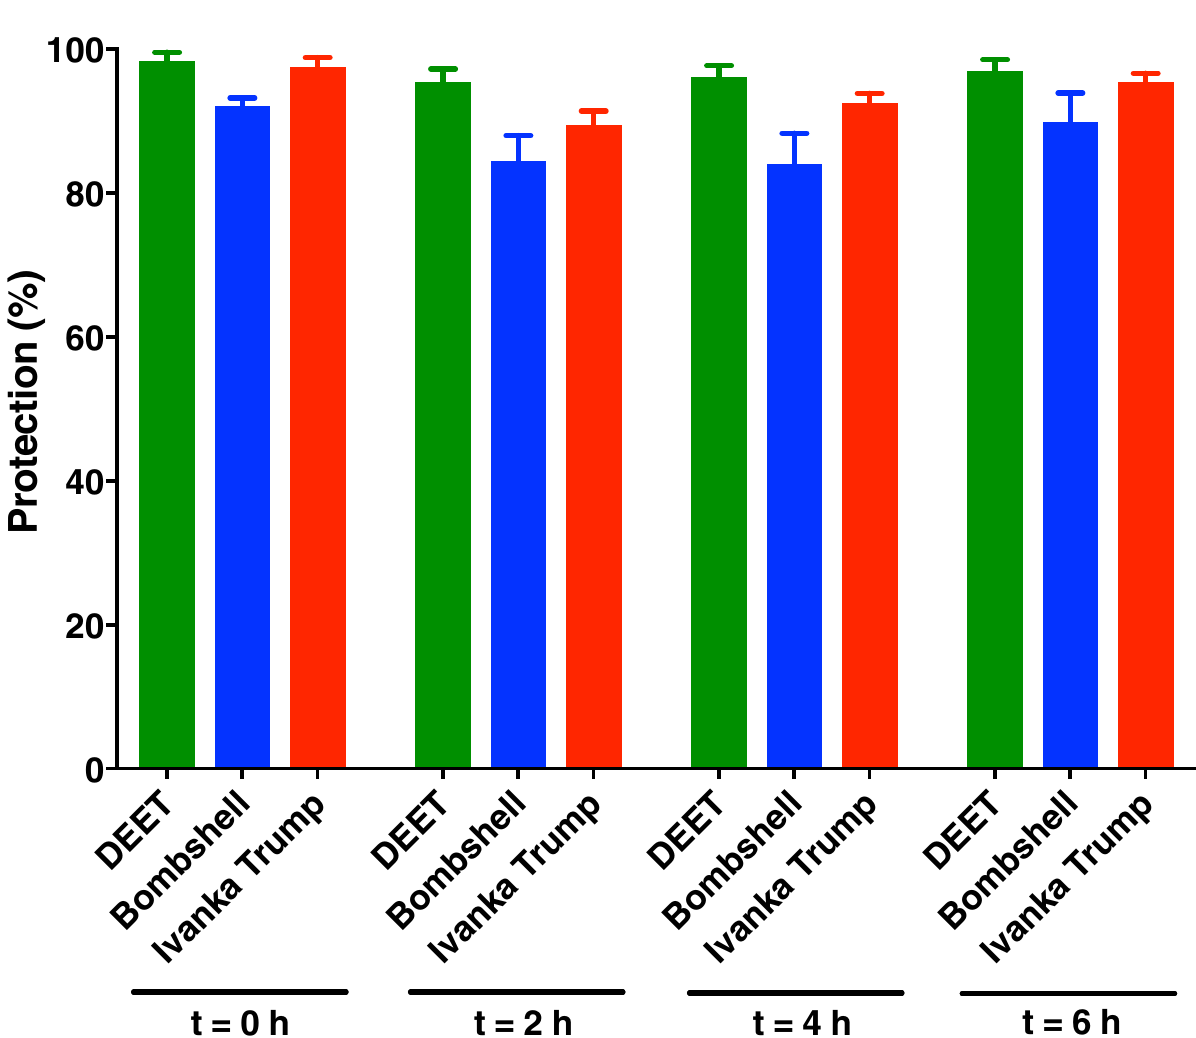
Fig 6. Repellence activity elicited by Bombshell and Ivanka Trump eaux de parfums over a period of six hours. DEET at 5% in our experimental setup, which is equivalent to a commercial formulation of 30% [13], was used as positive control. The perfumes were undiluted in these tests. Data are expressed in protection (%), representing the mean ± SEM of 6 replicates